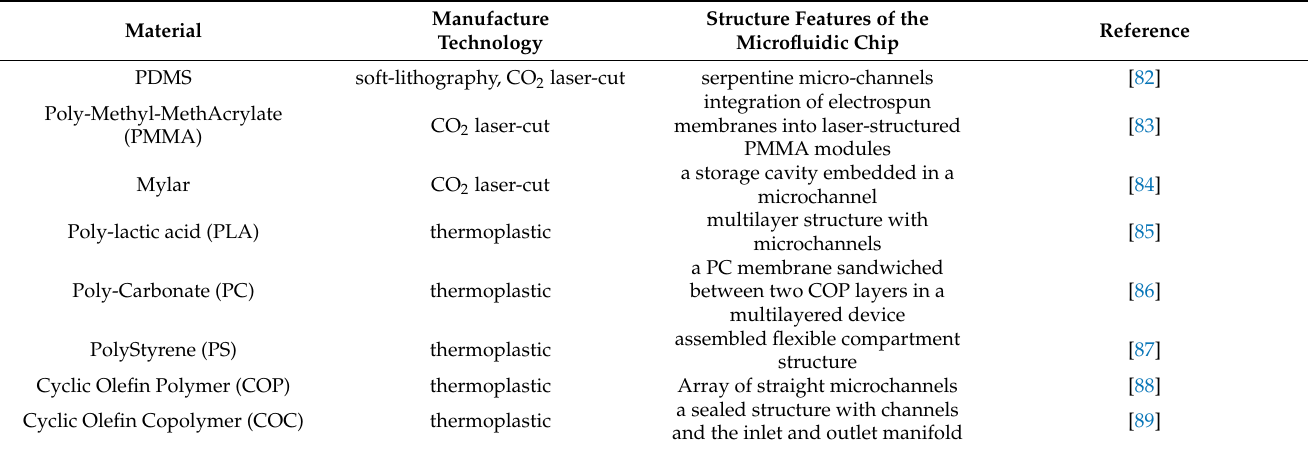
Table 2. The available materials of microfluidic chips in the engineering of an